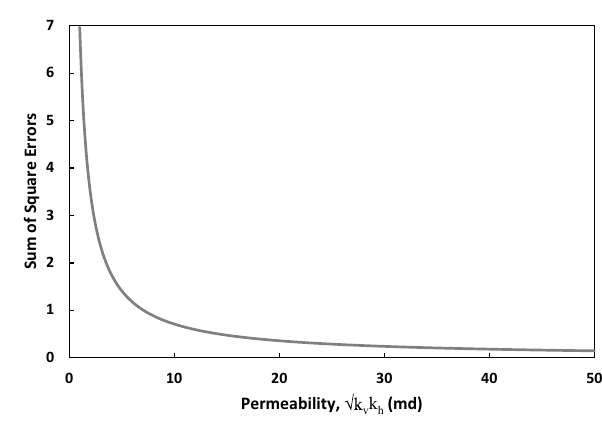
Fig. 8 The impact of permeability (√ k pseudo-pressure before and after correction